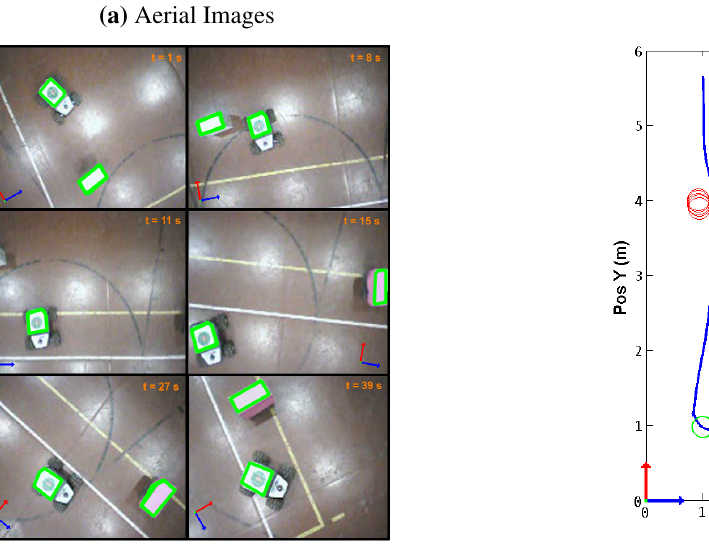
Figure 13. Field tests: ( a ) Sequence of images obtained from the UAV while performing an obstacle-avoidance maneuver. The orientation is represented with a blue and red arrow for the X and Y axes. ( b ) The UGV trajectory read from the EKF is shown in blue, additional marks for the target and the obstacle have been added.